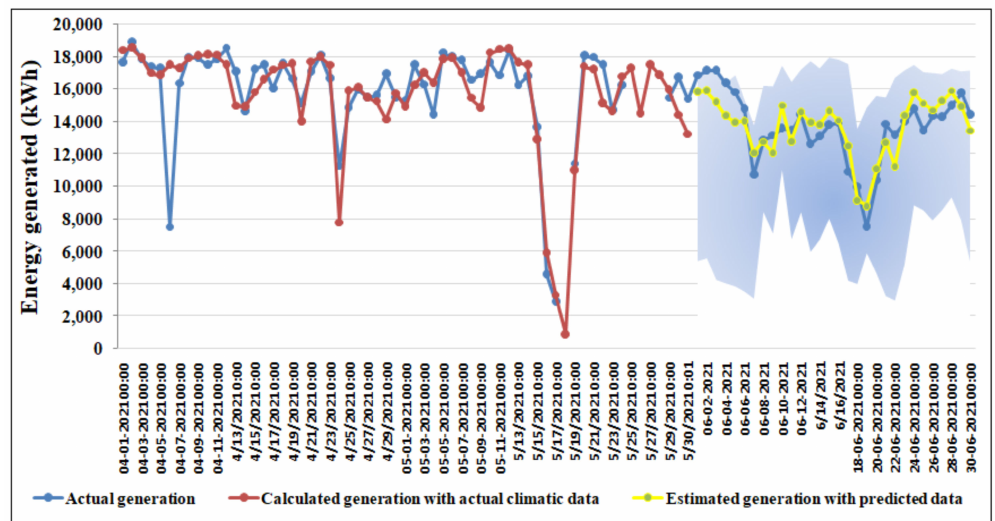
Figure 10. Model based PV generation prediction for 3 MW P PV plant in Gujarat,